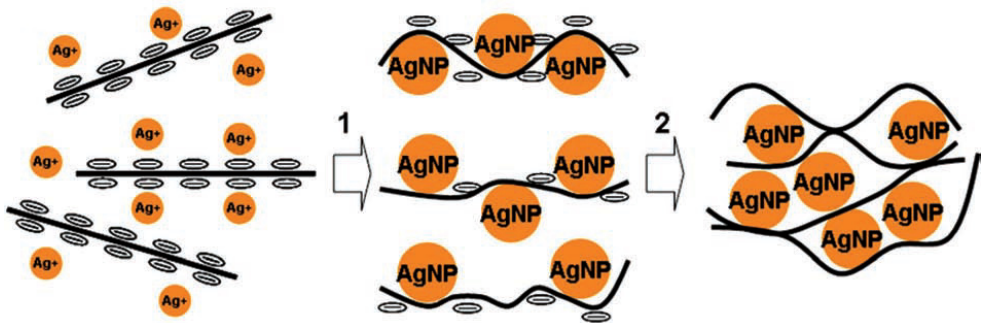
Figure 6. Schematic diagram of how the AgNPs are formed in the space between the graphene flakes during the reduction. Reproduced from [31] with permission from John Wiley and Sons. Copyright 2012.